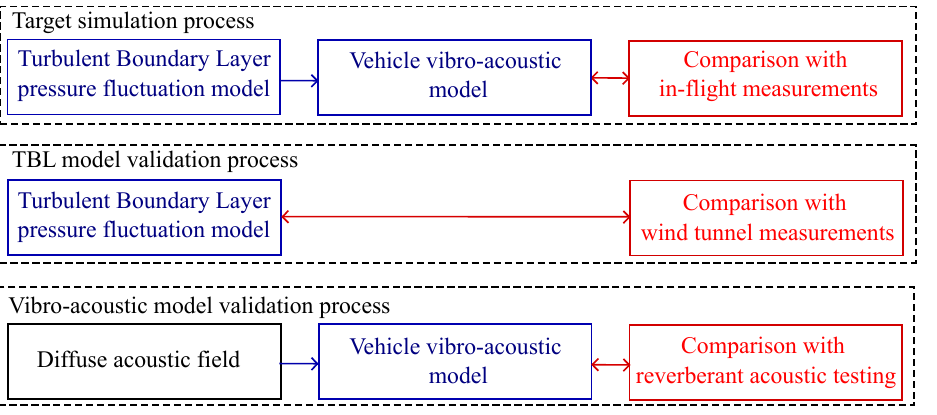
Figure 1. Simulation and validation processes. The blue rectangles represent steps where various models can be chosen. The “Diffuse Acoustic Field” rectangle is colored black because it corresponds to a unique analytical definition. The red rectangles represent comparison with the experiment